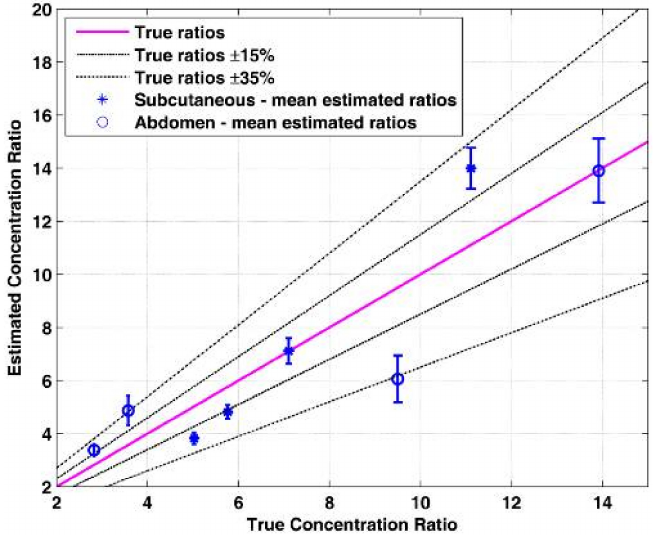
Figure 1. The estimated concentration ratio as a function of the true concentration ratio. The solid line represents the true ratio values. The star symbols represent the average estimated ratios of the subcutaneous tubes with their 90% confidence interval. The circle symbols represent the average estimated ratios of the abdomen tubes with their 90% confidence interval. The dotted lines represent the true ratio values with 15% errors and the dash-dotted lines represent the true ratio values with 35%